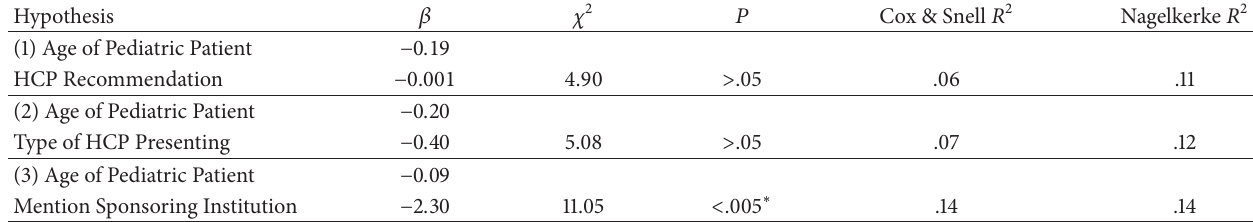
Table 3: 𝛽 Weights and Chi-Square Results for Logistic Regression